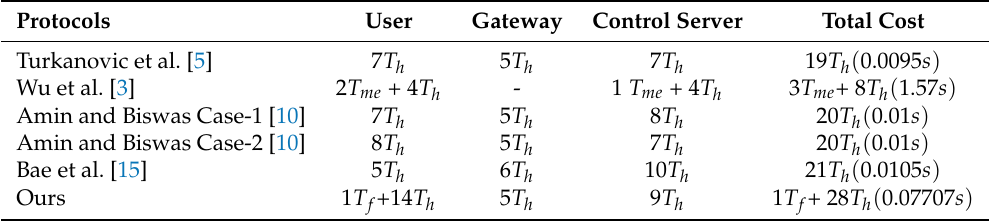
Table 4. Computation cost of the login and authentication